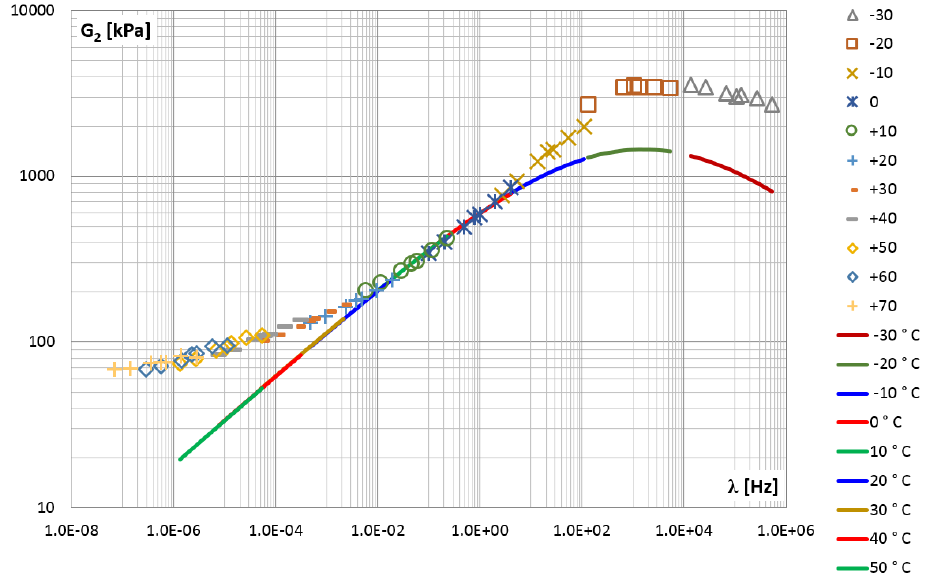
Figure 19. The shear loss modulus G 2 vs. frequency—master curve.